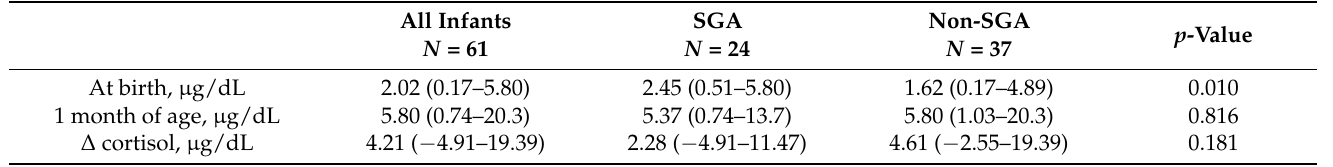
Table 5. Comparison of plasma cortisol levels between SGA and non-SGA